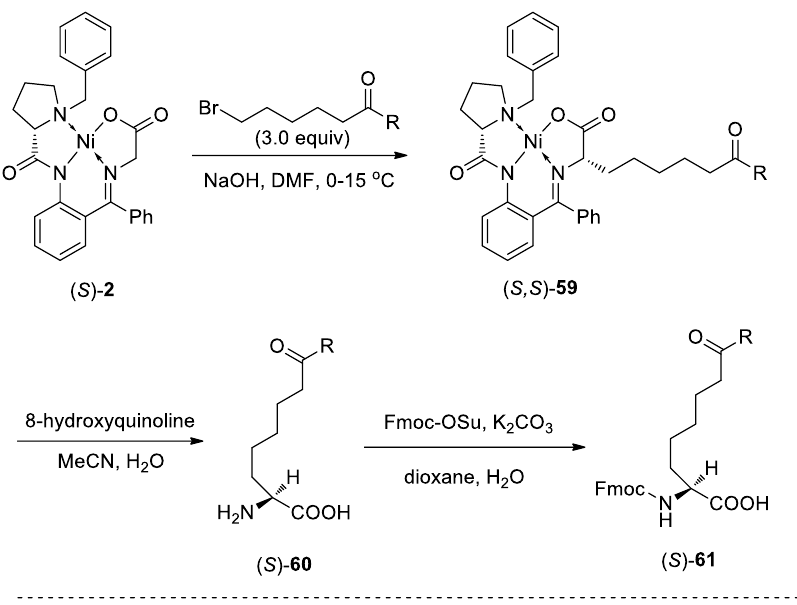
Scheme 21. An improved synthesis route to α,α -disubstituted amino acid derivatives.